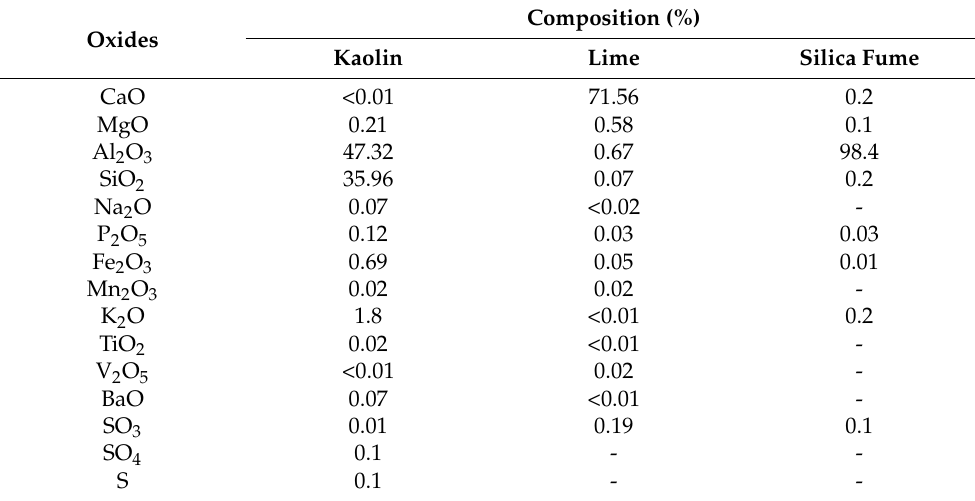
Table 1. The different oxide compositions of some of the raw materials used in this study. Composition (%) Oxides Kaolin Lime Silica Fume CaO